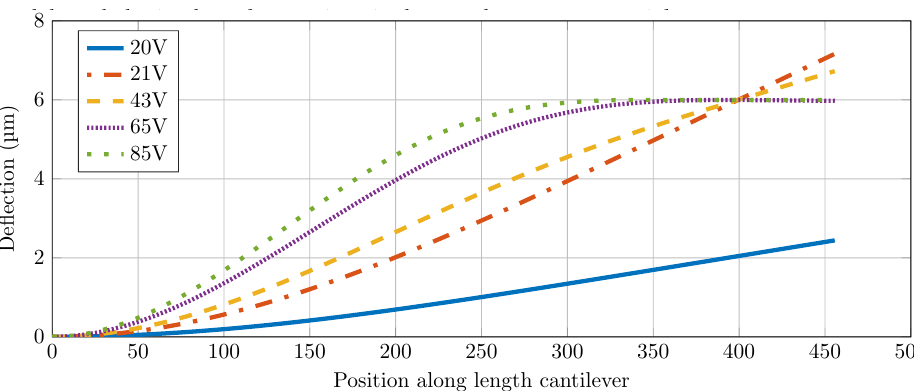
Figure 5. The shape of the cantilever is shown as a function of the position along the length of the